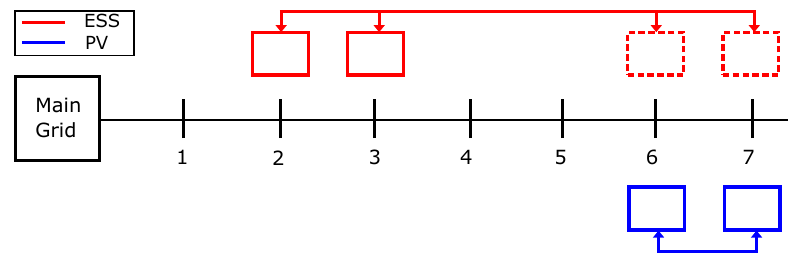
Figure 3. LV grid with virtual